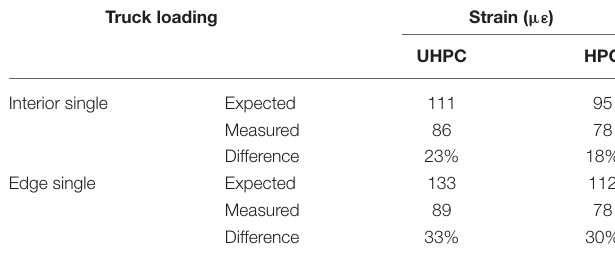
TABLE 6 | Stage 1 load test: expected vs. measured